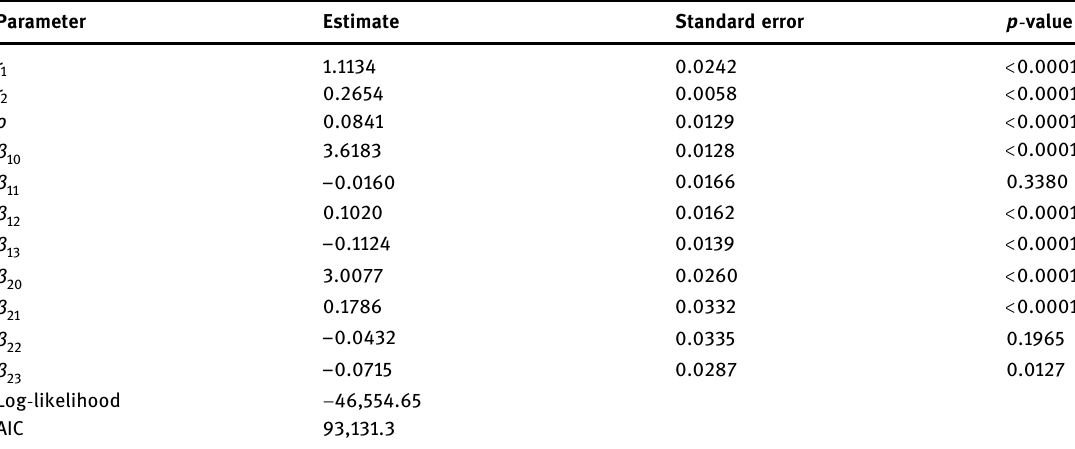
Table 4: Parameter estimates for = m 0 Parameter